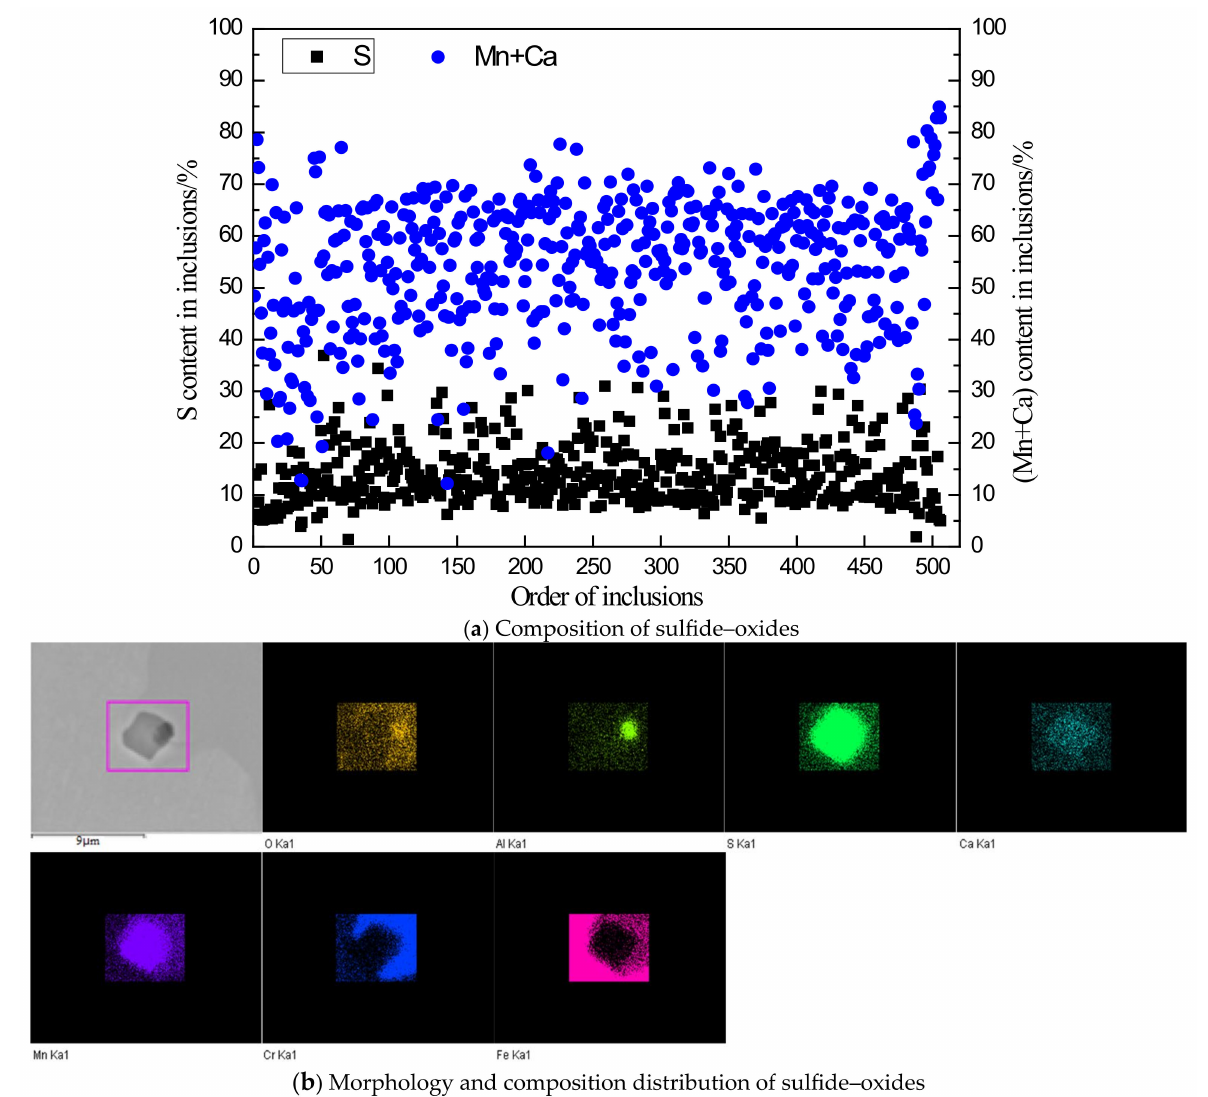
Figure 6. Composition and morphology of sulfide–oxides in the consumable